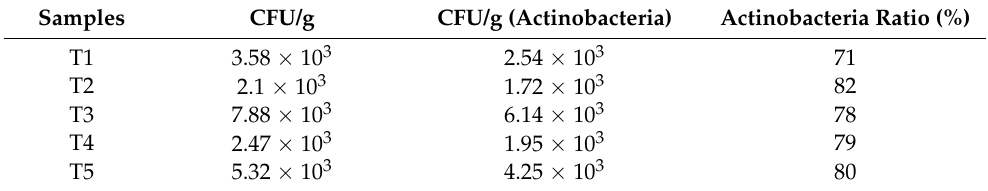
Table 2. Microbial count (CFU/g) by culture detection in Flaming Mountain samples.